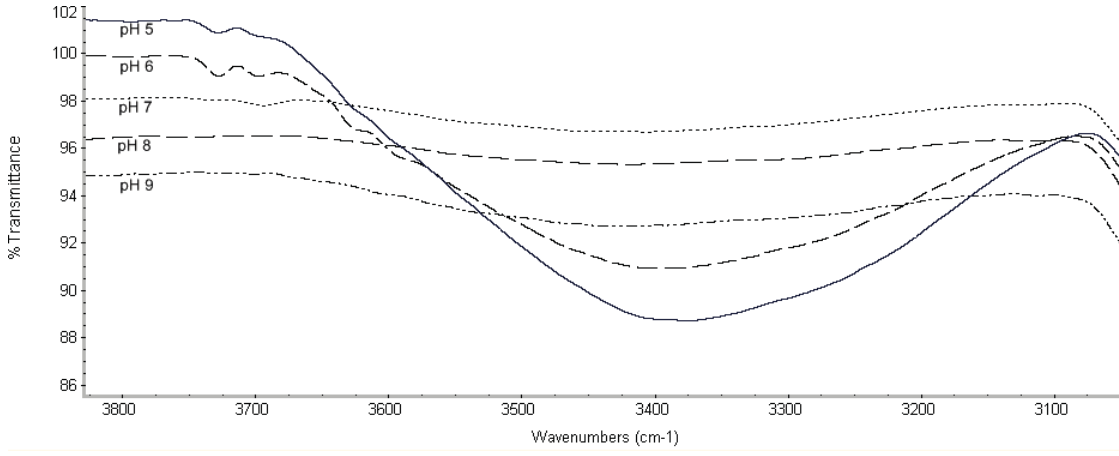
Figure 4. FTIR spectra (3000–3800 cm − 1 ) of LNR samples prepared at different pH of